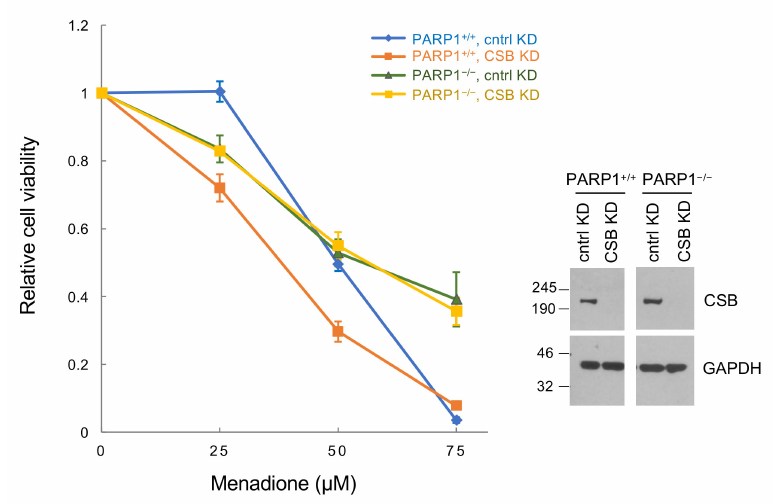
Figure 6. Menadione sensitivity assays. PARP1 +/+ and PARP1 − / − RPE cells expressing shRNA targeting CSB or a control shRNA were treated with menadione at the indicated concentrations for 1 h. Cell viability was determined by trypan blue exclusion 24 h after treatment. The extent of CSB knockdown is shown to the right. Shown are means +/ − SEM from three biological